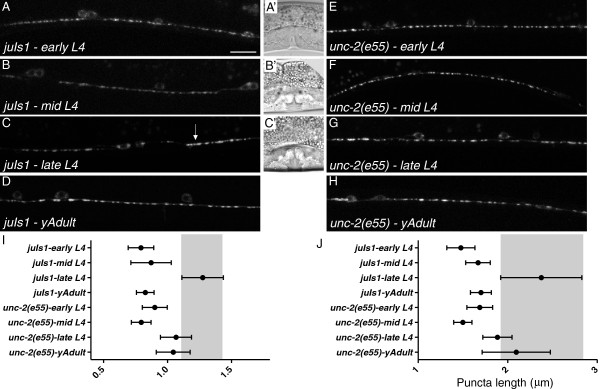
Wild type (wt) animals have enlarged puncta during late 4th larval stage (L4) development. During the early (A) and mid (B) L4 stage SNB-1::GFP puncta in wild type animals were evenly sized and spaced. (C) But during late L4 puncta were often enlarged and/or elongated (arrow) along the axon. (A’-C’) Representative examples of vulval progression used to mark transition from early (A’), mid (B’) and late (C’) phases of L4 development. (D) In young adults puncta were again evenly sized and spaced. In unc-2 mutants the early (E) and mid (F) L4 stage animals had evenly sized and spaced puncta, that appeared enlarged in late L4 (G), but not elongated. (H) Puncta remained enlarged in young e55 adults, compared to those in equivalently aged wild type animals (D). (I) Plots of the puncta length in the different stages are presented as means (circles) with the 5 to 95% confidence intervals (whiskers). During late L4 of wild type (area also shaded for comparison), puncta are longer, and more variable in length, than during other periods imaged. By comparison, during late L4, although longer than wild type adults, unc-2 mutants had only a modest increase in length. (J) A plot of the length of each puncta divided by the width for each genotype.